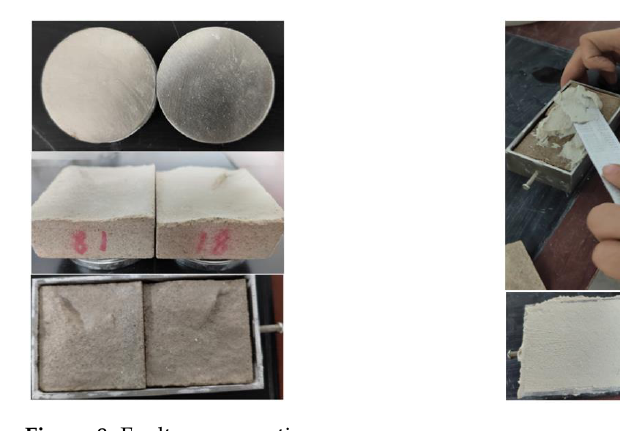
Figure 8 . Fault gouge coating process. Figure 8. Fault gouge coating process.